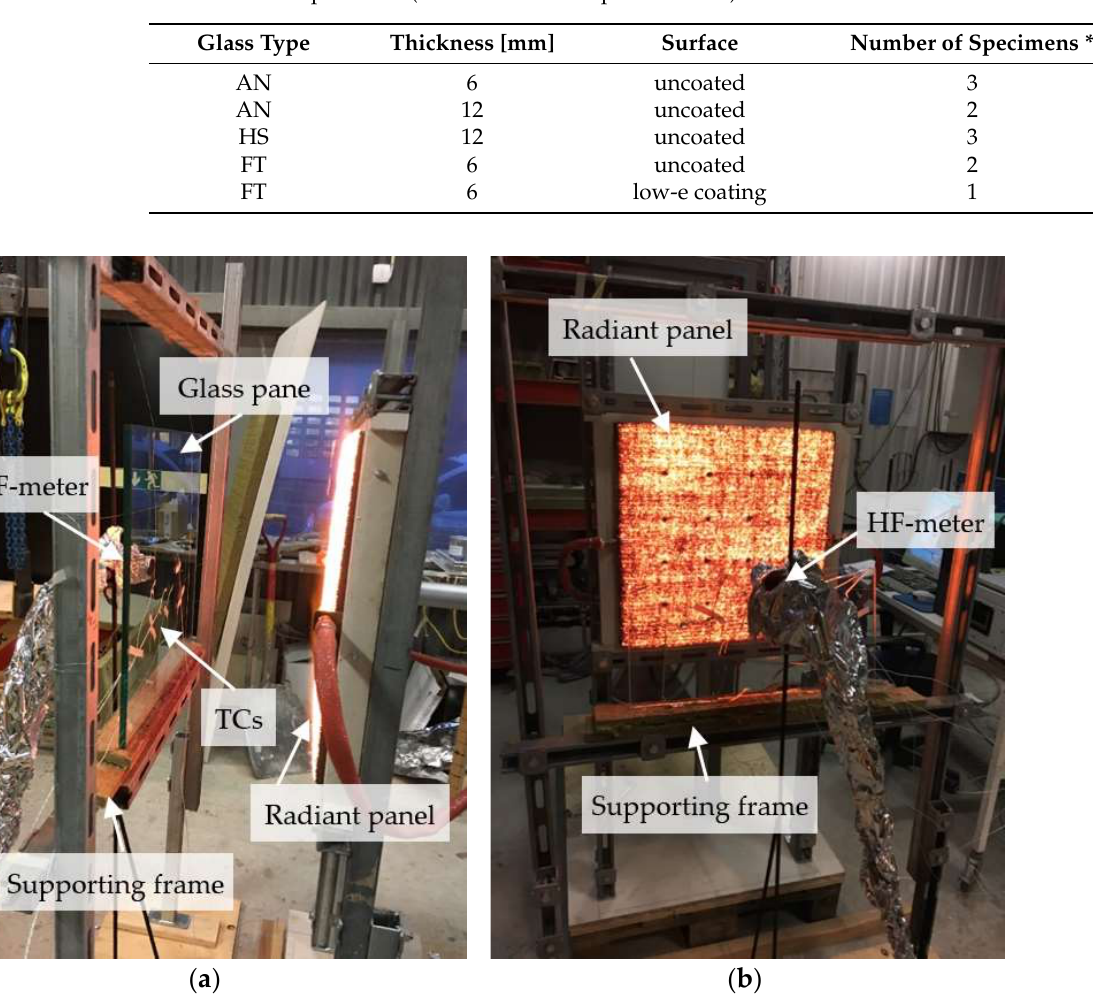
Table 1. List of specimens (* total number of specimens: 11).